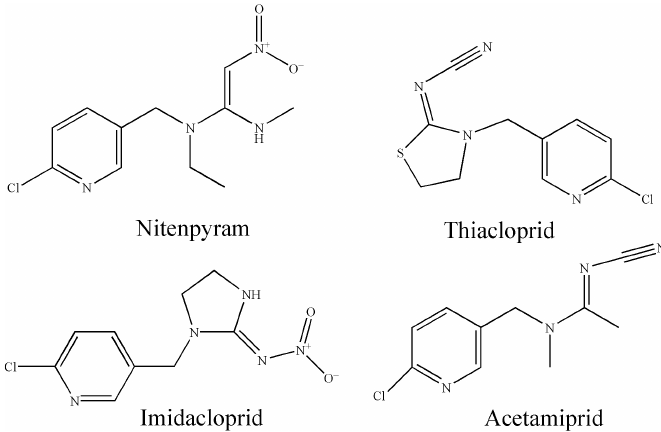
Figure 1. Chemical structures of four neonicotinoid insecticides.